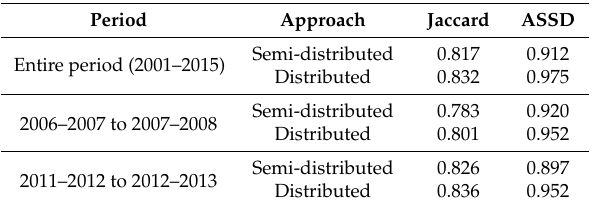
Table 6. Average values of the Jaccard index and average symmetric surface distance (ASSD) values for each simulation approach for various time